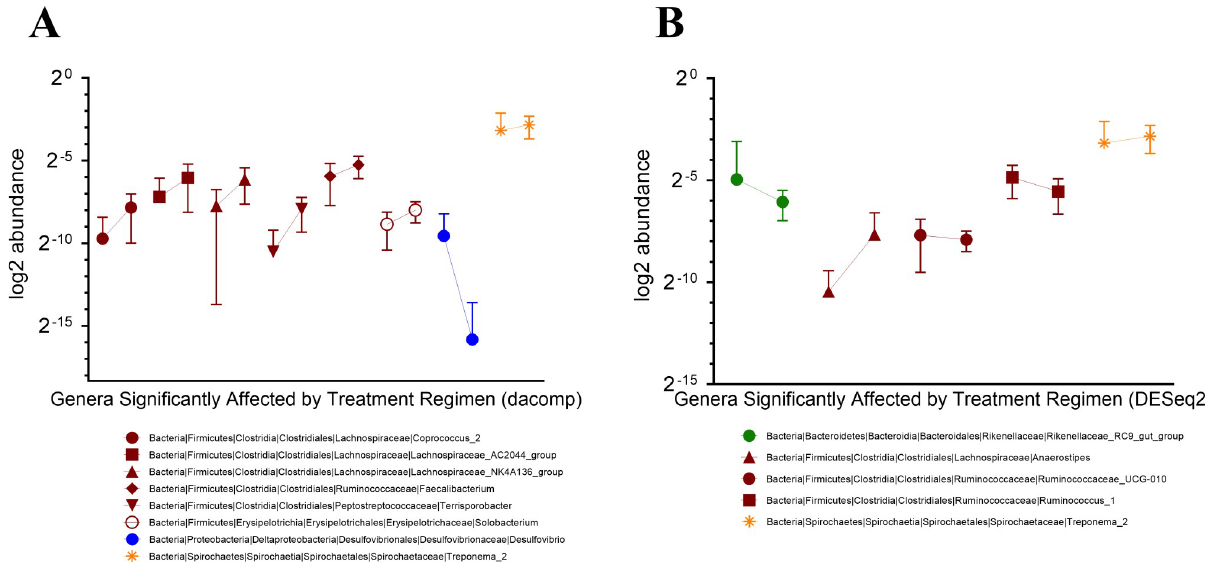
Fig 2. Multimodal therapy causes only a small subset of taxonomic genera to have microbiota community perturbances; enrichment of anti- microbial resistant Proteobacteria genera are not detected. (A) Dacomp and (B) DESeq2 analyses are used to assess for genera relative abundance differences for pre- and post-treatment timepoints for all study animals. Color distinguishes between different taxonomic phyla, shape/color distinguishes individual genera (see figure key), pre- and post-treatment timepoints are connected by a line for each genus. Genera classes jointly identified by the analyses are designated by ( � ). All genera differences represented by Dacomp and DESeq2 analyses are statistically significant (p-value < 0.004).